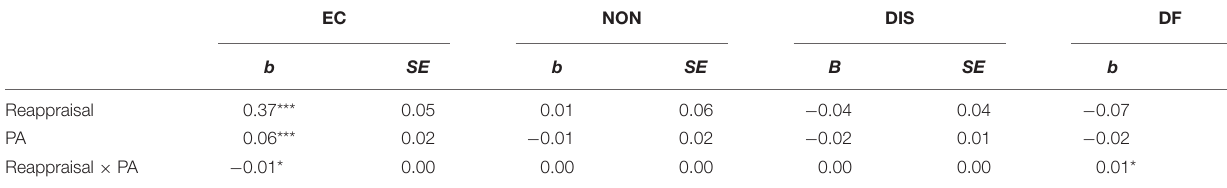
TABLE 3 | Parenting alliance and cognitive reappraisal predicting emotion